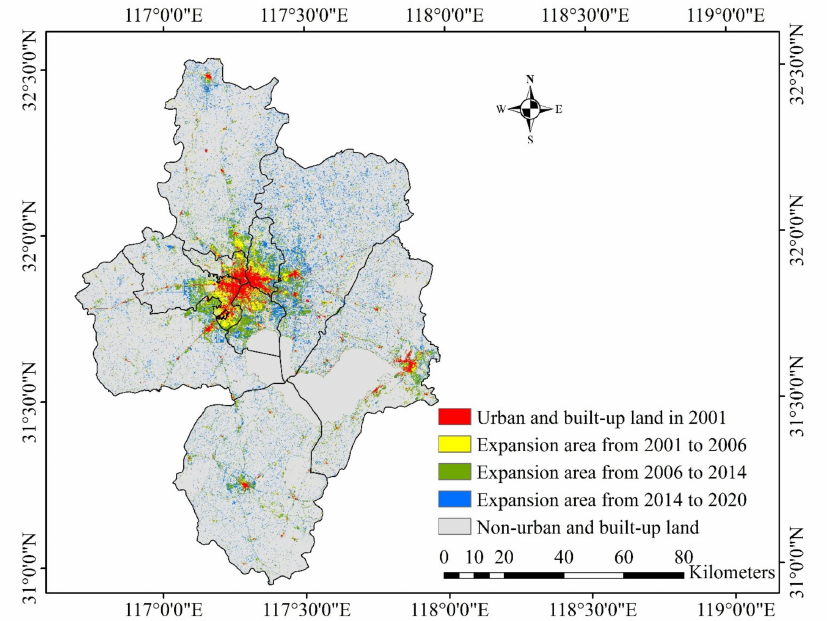
Figure 9. The urban and built-up land in 2001 and its expansion.